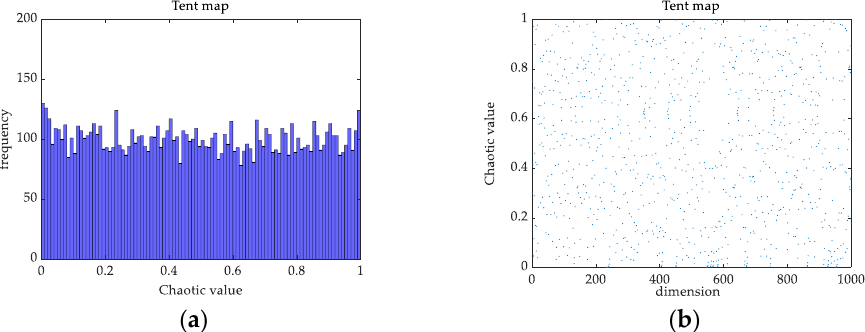
Figure 2. Tent chaotic sequence. ( a ) Histogram; ( b ) Distribution map.